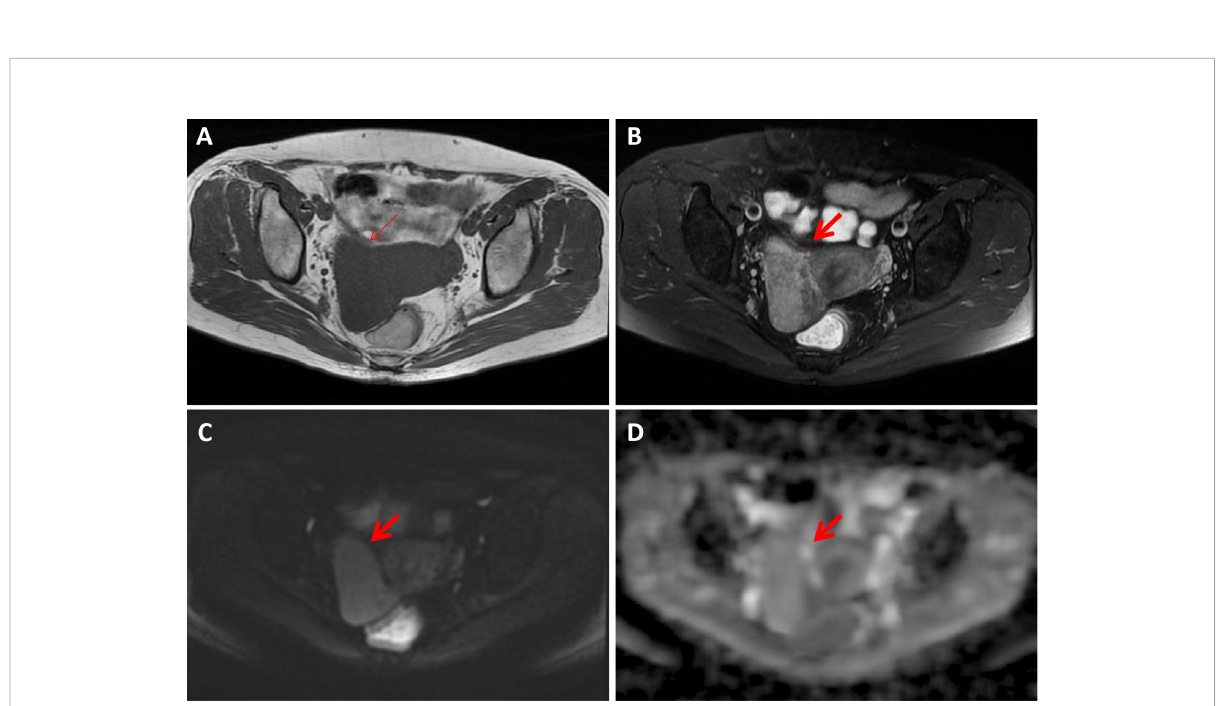
FIGURE 4 A 56-year-old woman with a hydropic degeneration leiomyoma. The mass was detected in the uterine right wall (arrow) with isointensity on T1WI (A) and heterogenous iso-to-hyperintensity on T2WI images (B) . The tumor showed high signal intensity on diffusion-weighted MR image (C) with a high ADC value (ADC = 1339 × 10 -6 mm 2 /sec) (D)